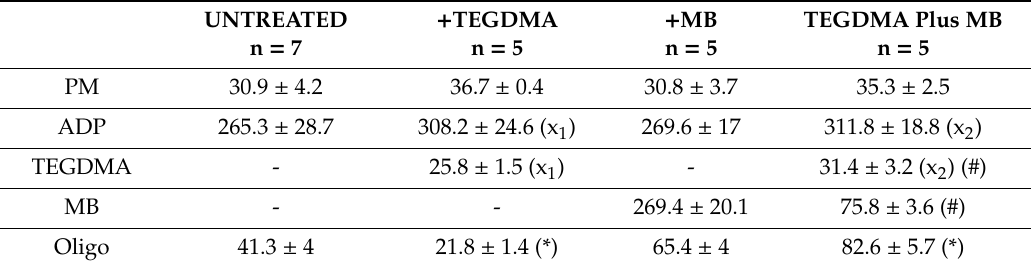
Table 2. Effects of TEGDMA on oxygen consumption of brain mitochondria supported by pyruvate plus malate, in the presence or absence of methylene blue.